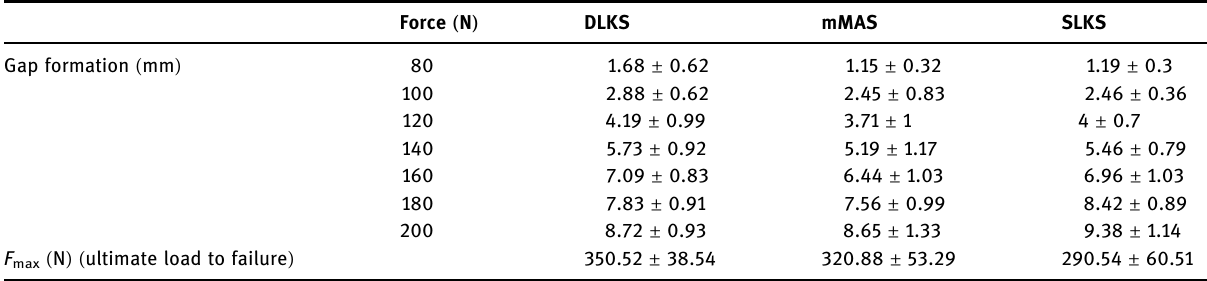
stitch technique